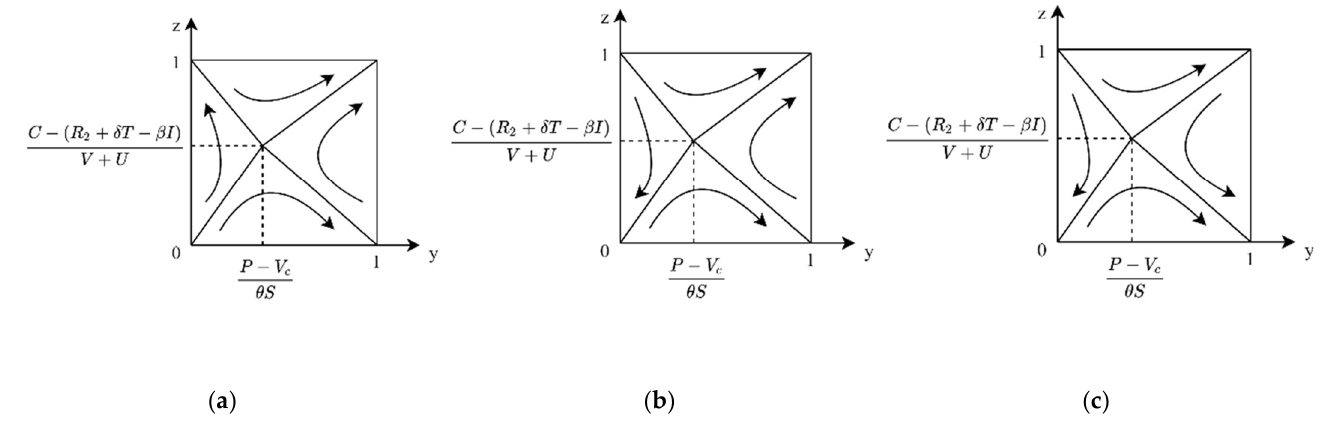
Figure 5. Evolutionary phase diagram of cost–benefit of enterprise under C < βI + δT + R 2 . ( a ) When the price is lower than the product value. ( b ) When the price is slightly higher than the product value. ( c ) When prices are much higher than the product value.